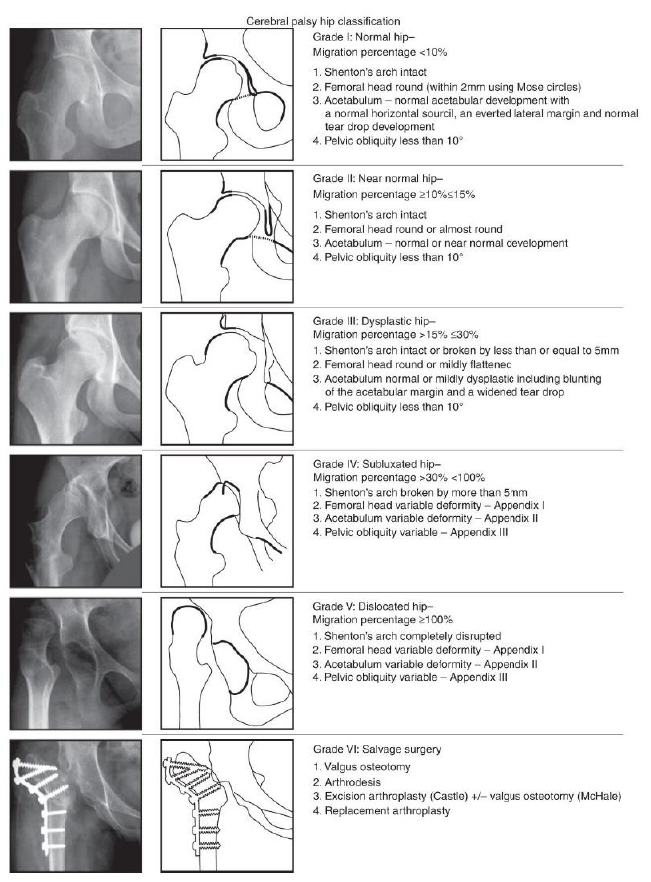
Figure 1. Radiographs and diagrams showing The Melbourne Cerebral Palsy Hip Classification Scale (reproduced)